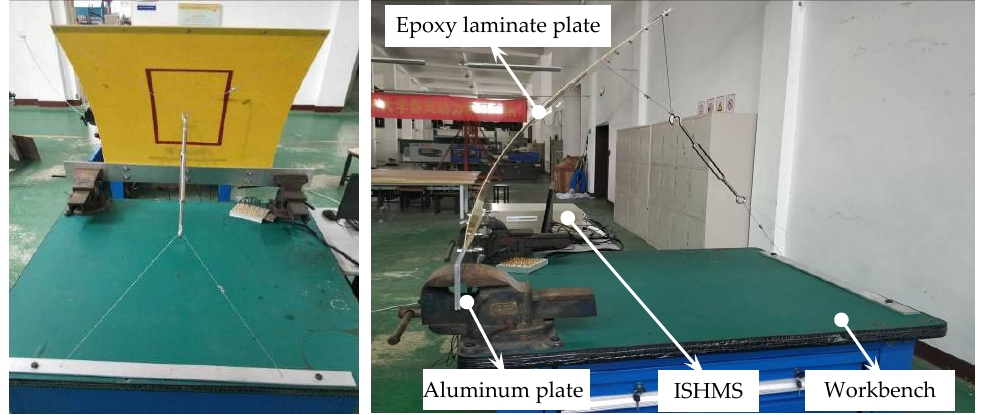
Figure 9. Schematic of experimental setup for Load testing.